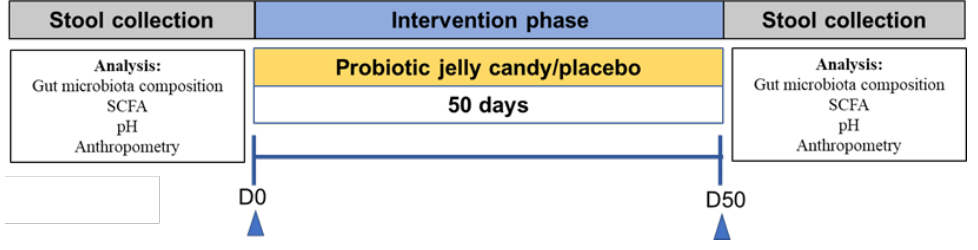
Figure 1. Research design. SCFA: Short-Chain Fatty Acid.